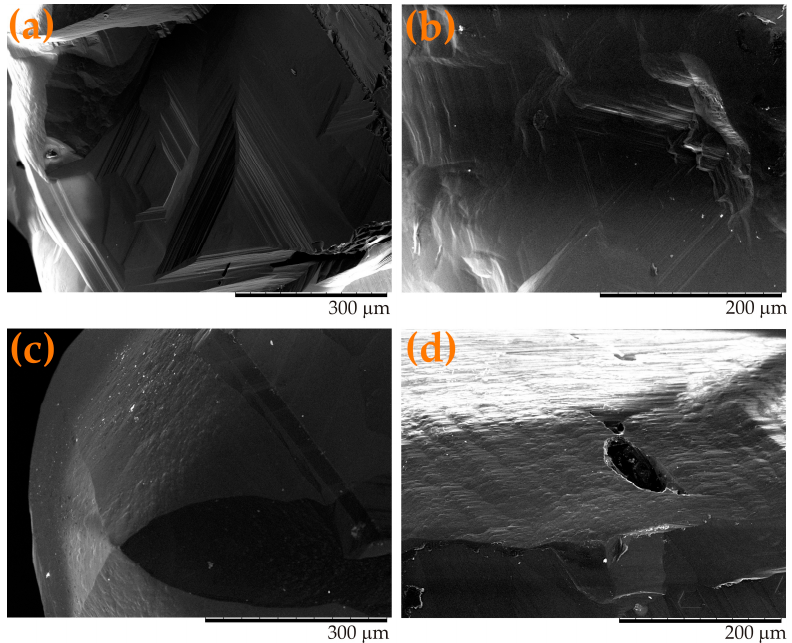
Figure 4. Surface microrelief features of super-deep diamonds (backscattered electron image). ( a ) Triangular etch pits on the relics of (111) plane, Sample HH-11; ( b ) Sample SL-34; ( c ) drop-shaped hillocks on the rounded surface of SL-2 diamond; ( d ) striation on the rounded surface of SL-55 diamond.